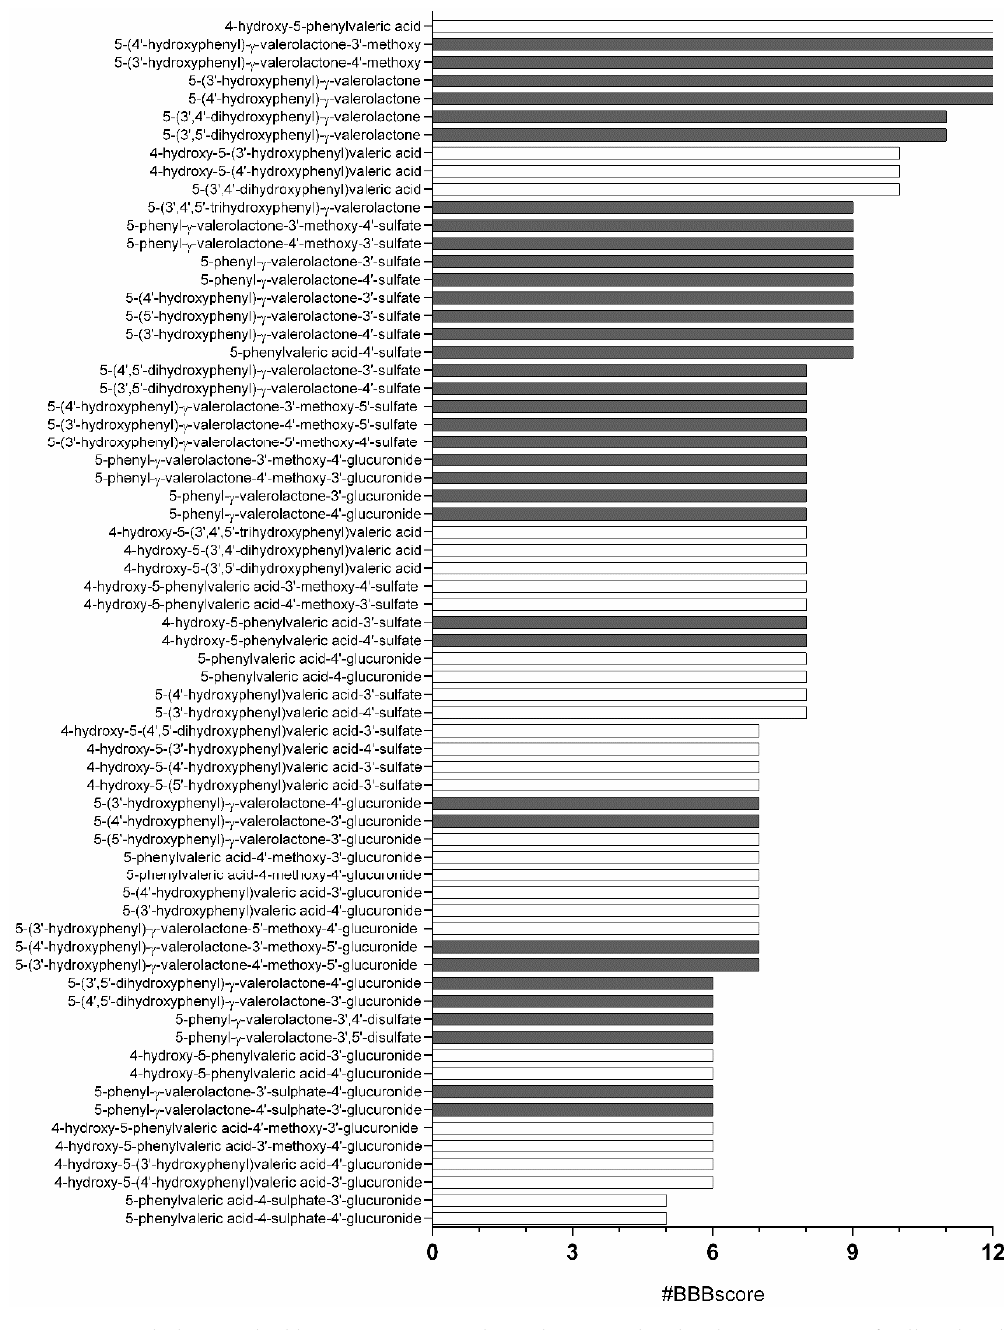
Figure 4. Metabolites ranked by #BBBscore. Twelve QikProp molecular descriptors specifically related with BBB permeability were used to define a score. Black bars correspond to PVLs and white bars to PVAs.